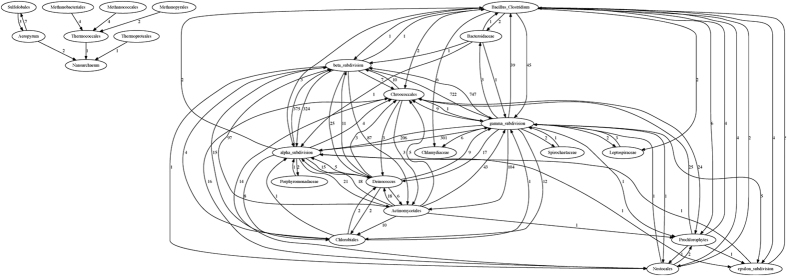
The LGT network inferred for the BA dataset grouped by class.The numbers on each edge show the total number of genes involved in LGT events from one group into genomes in the other group.